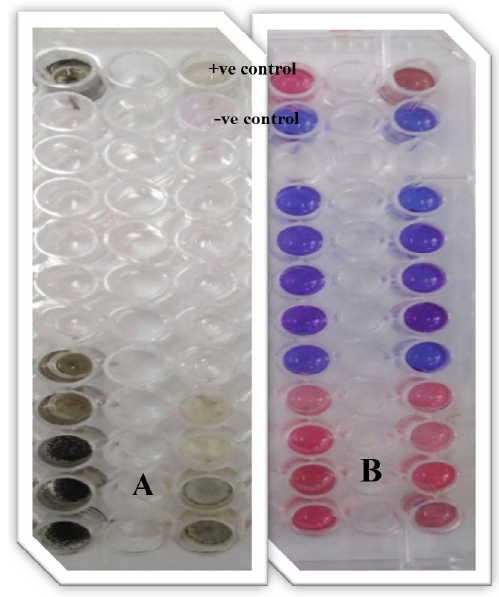
Fig. 16. Ninety-six well Microtiter plates of the colorimetric-XTT assay for determination of MIC values of ZnO NPs against fungal isolates. A: multi cellular fungi (1- A. niger and 2- P. marneffie ), B: unicellular fungi (3- C. glabrata and 4- C. parapsilosis using resazurin salt).